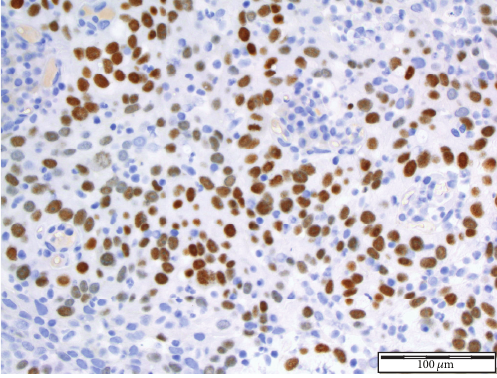
Figure 7: Immunohistochemical staining for 34bE12 (34 𝛽 E12) × 20 magnification. Lymphoepithelioma-like carcinoma of urinary bladder: the neoplastic cells stain positive for 34bE12 (34 𝛽 E12).